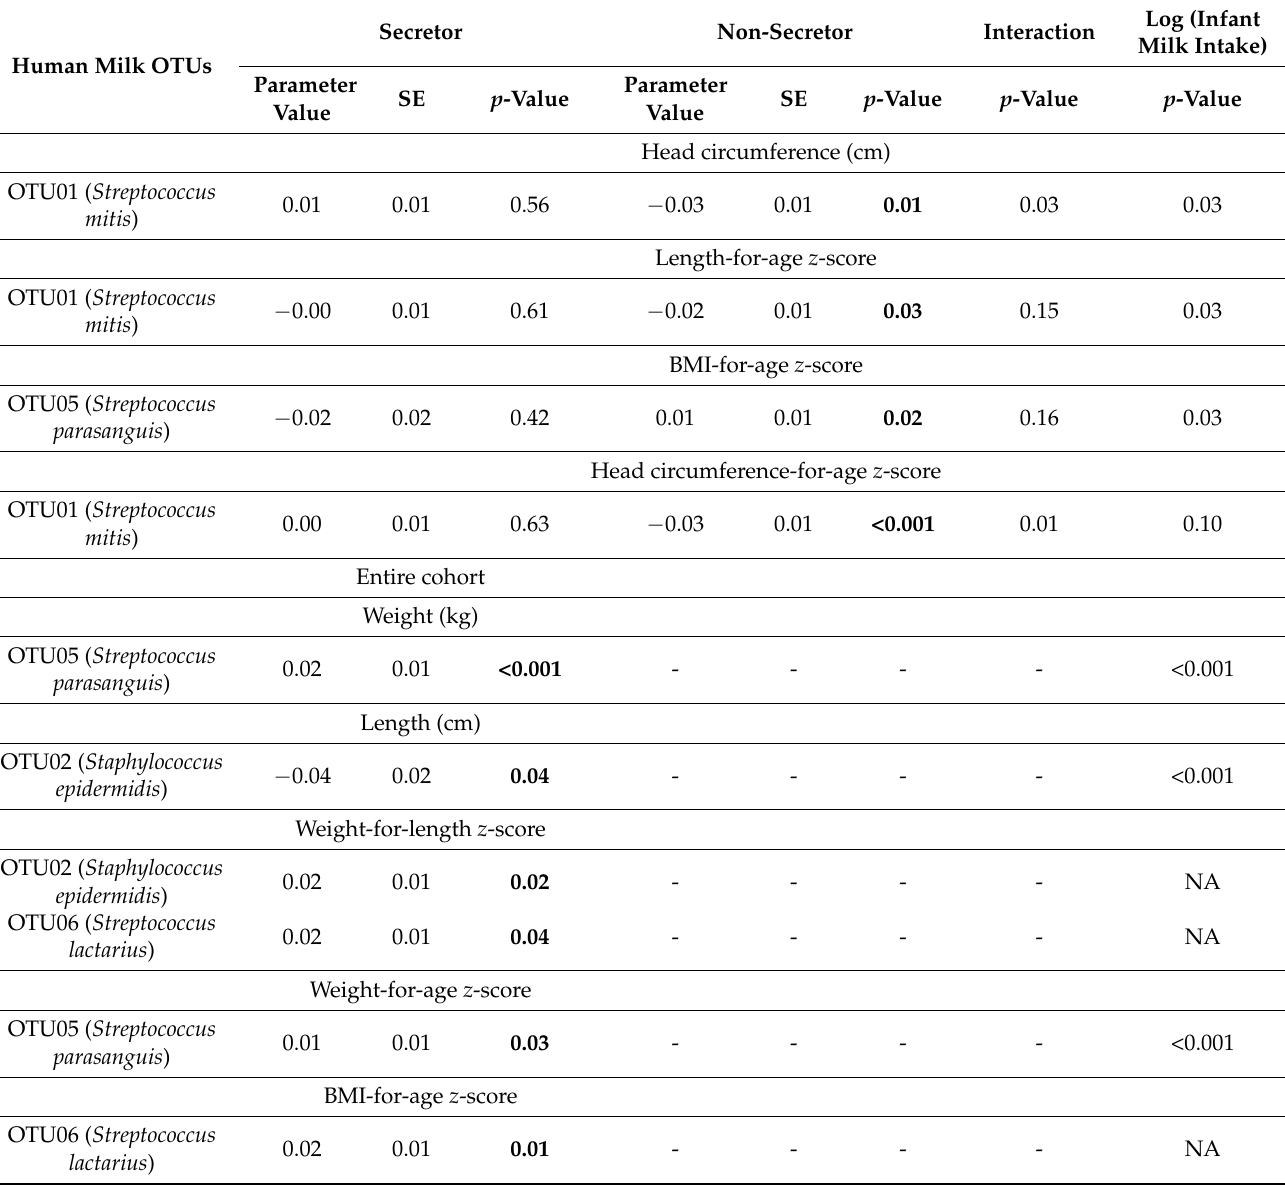
Table 5. Associations between bacterial OTUs and infant body composition at three months